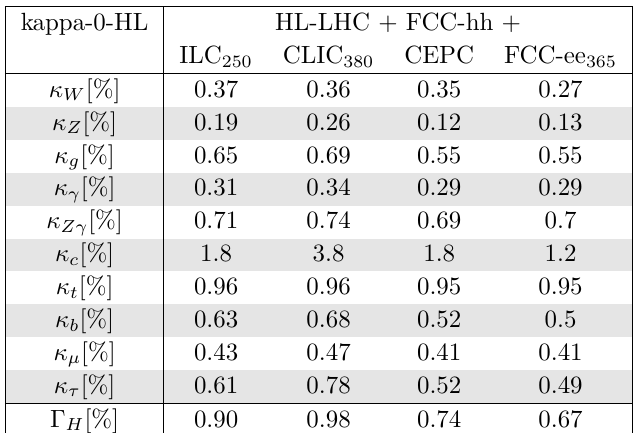
Table 31 . Results for the kappa-0-HL (cid:12)t for FCC-hh combined with any of the four e + e proposed.